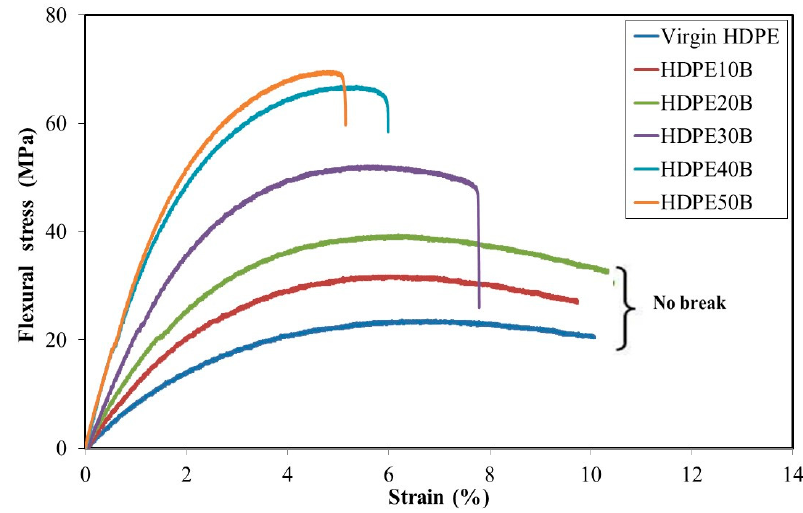
Figure 3. Flexural test: stress–strain behavior of HDPE/birch wood composites.